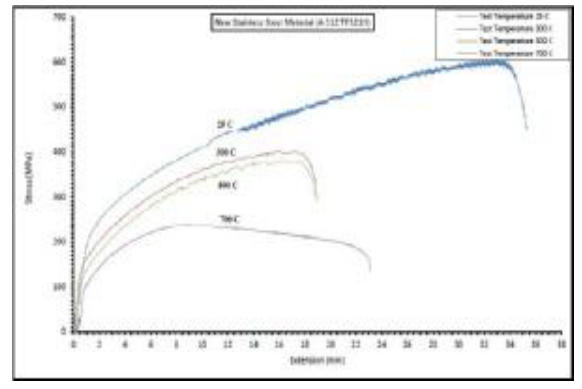
Fig. 6. Stress-strain curve under different temperatures for un-used austenitic stainless steel 321H.